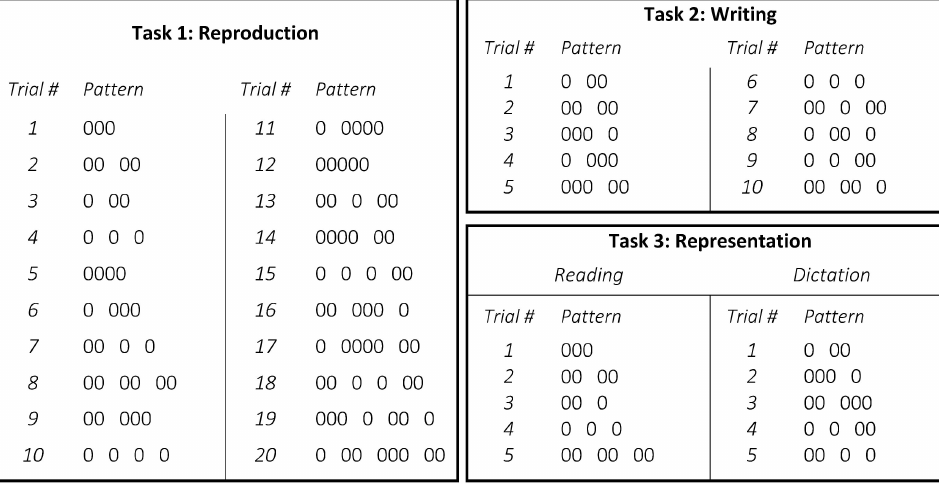
Figure 2. Reproduction, writing, and representation of the tasks of Stambak’s test. Circles correspond to beats and spaces between circles to